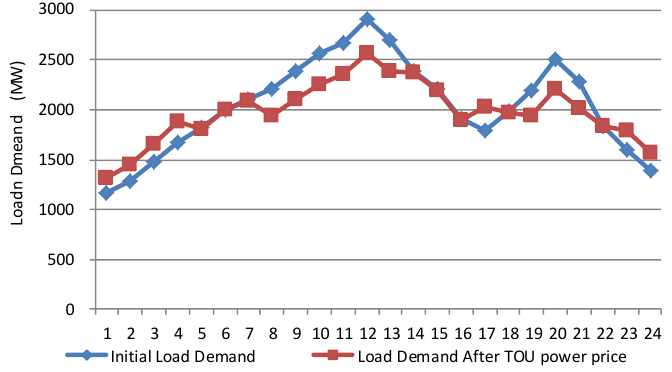
Figure 5. Load demand curve before and after considering demand response.